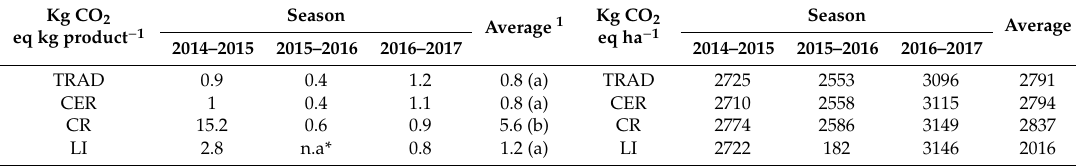
Table 5. Carbon footprint (kg CO 2 - eq kg product − 1 and kg CO 2 - eq ha − 1 ) for four di ff erent management programs established in a winter cereal field during three consecutive